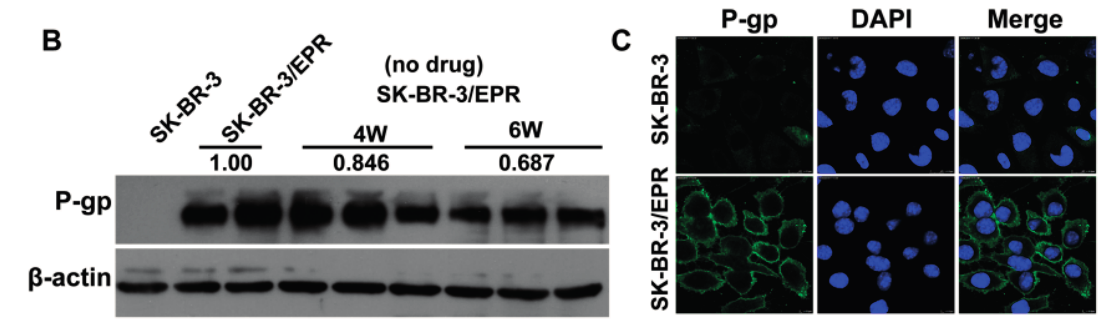
Figure 3. The SK-BR-3/EPR cells maintained MDR phenotype after sequential passages in epirubicin-free medium for six weeks. ( A ) Drug sensitivity assay of SK-BR-3 and SK-BR-3/EPR cells to epirubicin and paclitaxel. The SK-BR-3/EPR cells were cultured in epirubicin-free medium and sequential passages for six-consecutive weeks, then IC 50 assay was performed by using the CCK-8 based method; ( B ) Western blotting analysis of P-glycoprotein expression (P-gp) in SK-BR-3, SK-BR-3/EPR, and SK-BR-3/EPR cells cultured in drug-free condition for indicated times. The numbers above the blots show the relative values from the densitometric analysis. The levels of P-gp was normalized to β -actin, values are expressed as fold changes compared to SK-BR-3/EPR cells; ( C ) Confocal immuno fl uorescence